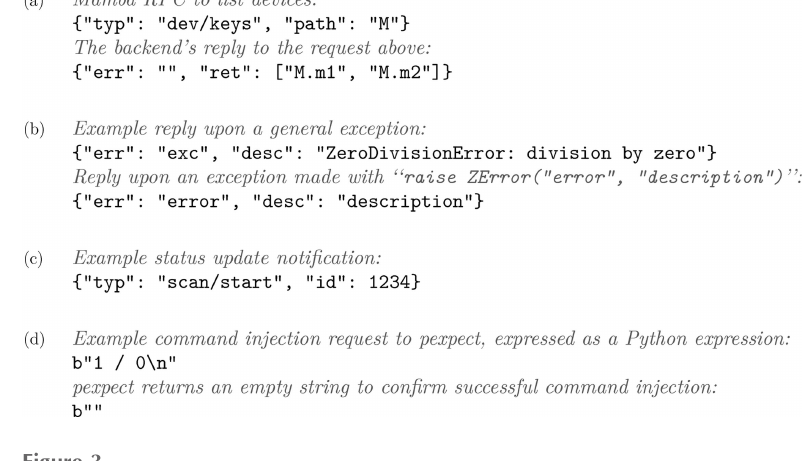
Figure 3 Example Mamba communication: ( a ) normal request/reply, ( b ) replies upon errors, ( c ) notification and ( d ) raw communication to pexpect ; except for ( d ), which uses raw byte strings, all other (RPC) communication uses a JSON-based format.